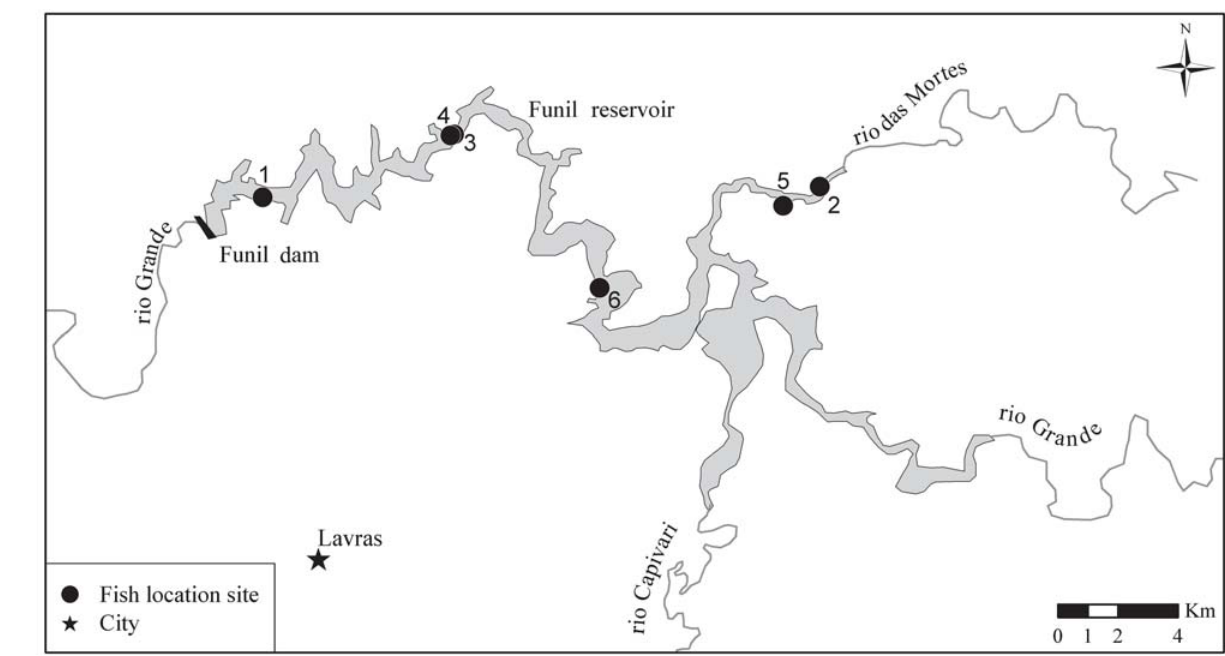
Fig. 1. Map of Funil Reservoir showing locations (%) of the tagged jaú. Location numbers as in Table